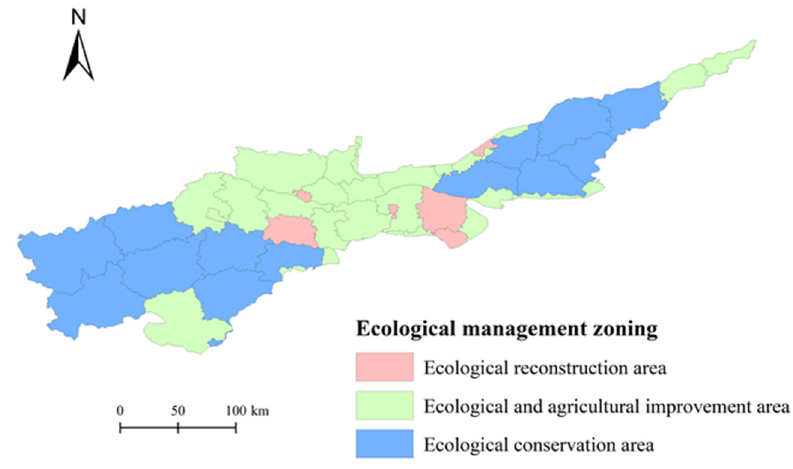
Figure 12. Ecological management zoning at the county level in the AYRHP.